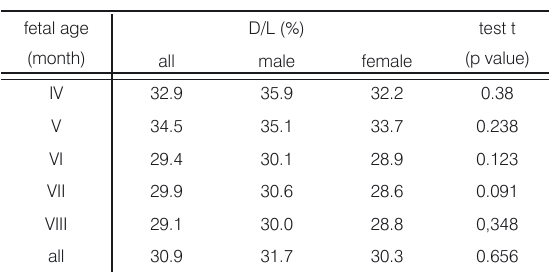
Table 3. Proportions of diameter and the length of coronary sinus between IV-VIII months of prenatal human life (D/L). Test t-Student show gender